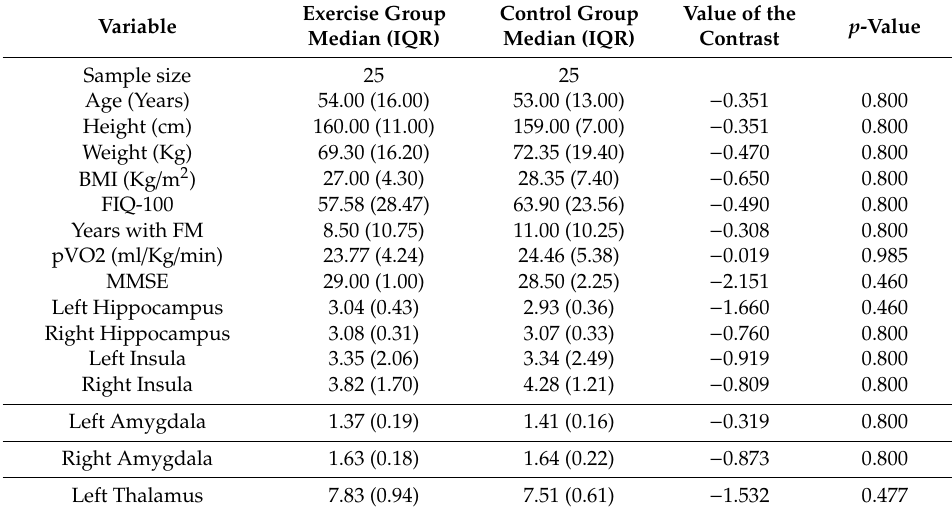
Table 1. Descriptive characteristics of participants and differences between groups at the baseline of fibromyalgia patients.